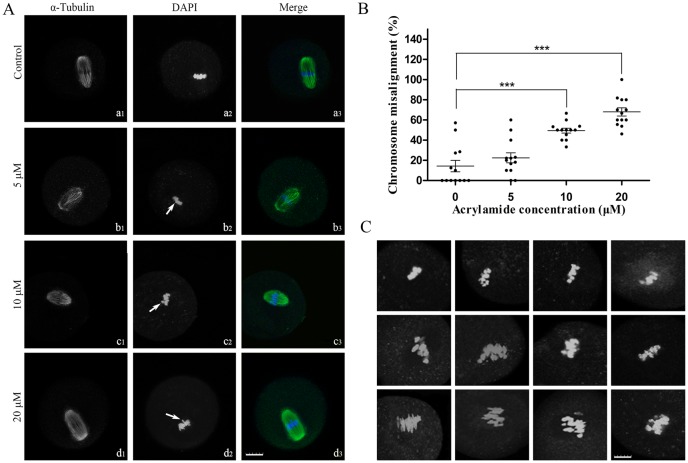
Effect of ACR on the chromosome and spindle of oocytes after ACR treated for 14h.After COCs were treated with ACR for 14h, cumulus cells were removed and the morphology of spindle and chromosomes configuration of oocytes was observed. (A) Representative confocal micrographs of spindle and chromosomes. Spindle morphology of oocytes was displayed in a1, b1, c1, d1 and nuclei was displayed in a2, b2, c2, d2. a3, b3, c3, d3 is the merge of (a1, a2), (b1, b2), (c1, c2), (d1, d2), respectively; Chromosome of oocytes was aligned (a2) in control group and misalignment (b2, c2, d2) in ACR-treated group. Arrows label the misalignment chromosomes. (B) The percentage of oocytes of chromosome misalignment in different group. Each dot in the coordinate represents one experimental data, and each group was 13 replicates. The percentage of chromosome misalignment = the number of chromosome misalignment oocytes / (the number of chromosome alignment oocytes and the number of chromosome misalignment oocytes).The data was compared using chi-square test and t-tests. Data are expressed as the mean ± SD. *** indicates P < 0.0001 vs. Control and means significant difference between experiment group and control group. (C) Images for various chromosome misalignment. 0 μM group: n = 110; 5 μM group: n = 139; 10 μM group: n = 146; 20 μM group: n = 137. Bar = 25 μm.